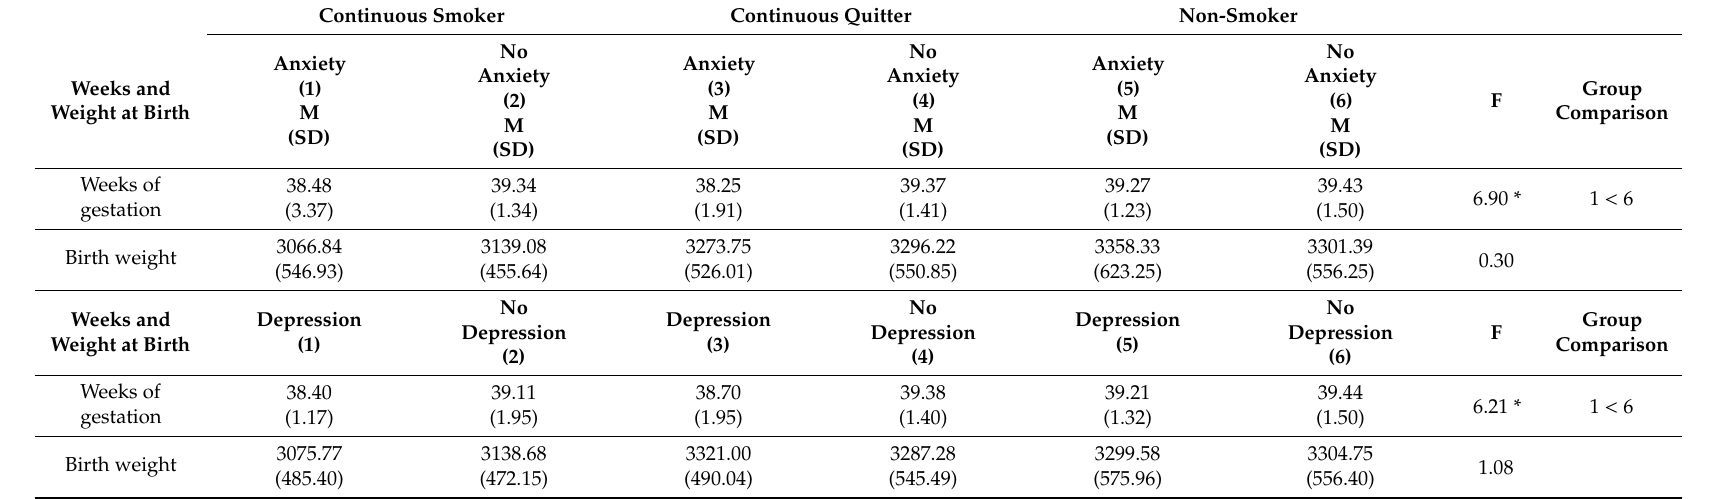
Table 4. Interaction of consumption status and anxiety or depression on weeks and weight at